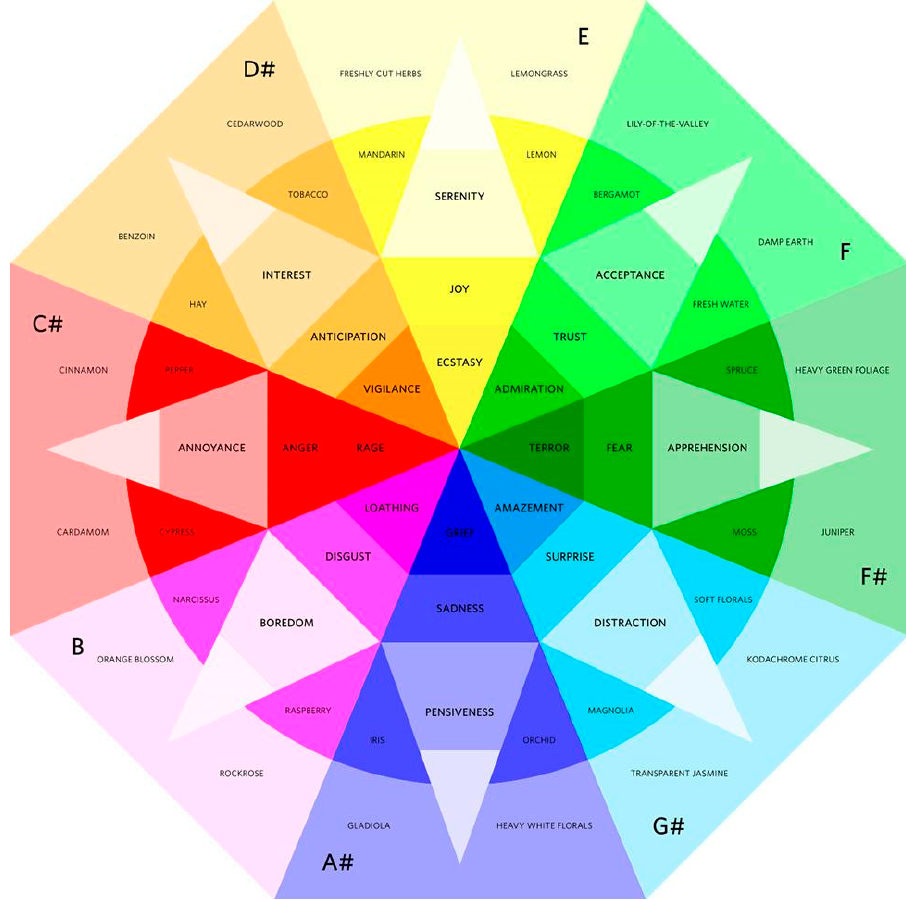
Figure 13. The emotion to color Plutchik wheel augmented with smell and sound by Lutyens. One could extend this to include corresponding textures and tastes for additional therapeutic ends.